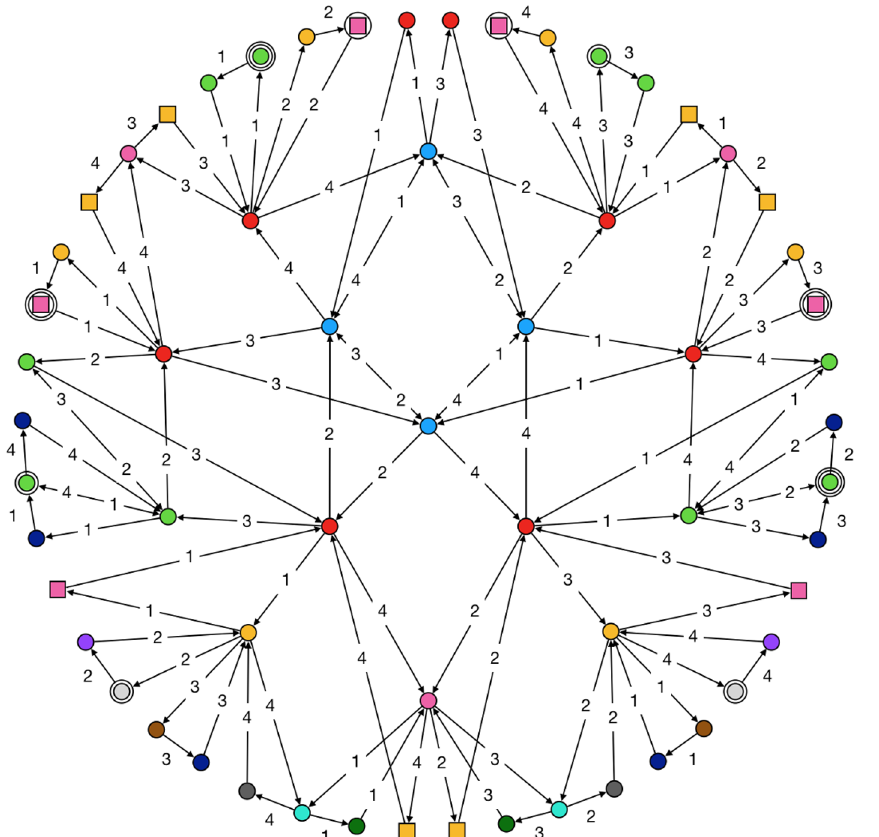
Figure 9. Duality web for the S n seeds with n > 2. The web is in(cid:12)nite and we only present a portion of it here. The seed, i.e. one of the S n theories, corresponds to the blue circle at the center of the